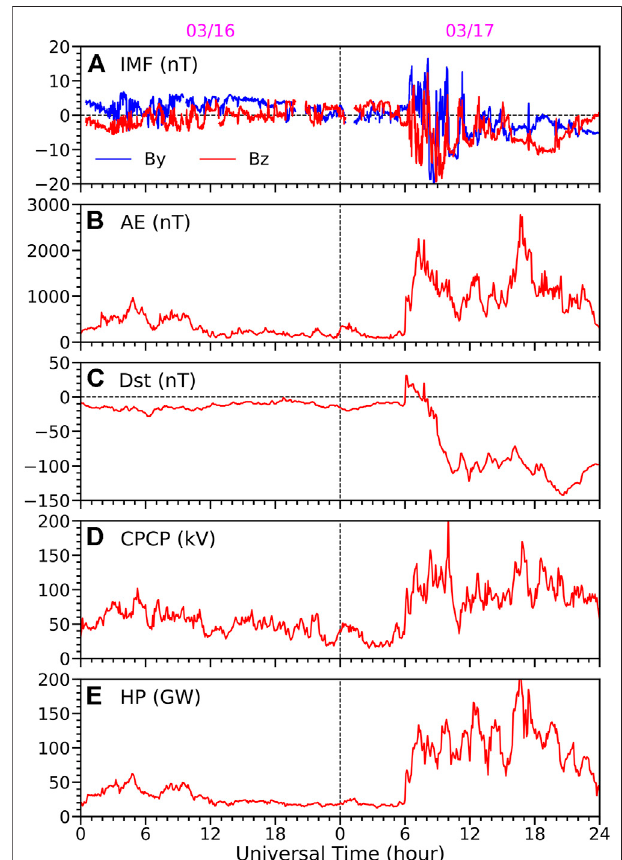
FIGURE 1 | Evolutions of (A) IMF (blue: B y ; red: B z ), (B) AE, (C) Dst, (D) CPCP and (E) HP during the 2013 St. Patrick ’ s day geomagnetic storm. The IMF data is shifted by 30 min. The parameters shown in the bottom four panels are from the Northern Hemisphere AMIE output. IMF, interplanetary magnetic fi eld; AE, auroral electrojet; CPCP, cross- polar cap potential; HP, hemispheric power; AMIE, Assimilative Mapping Ionospheric